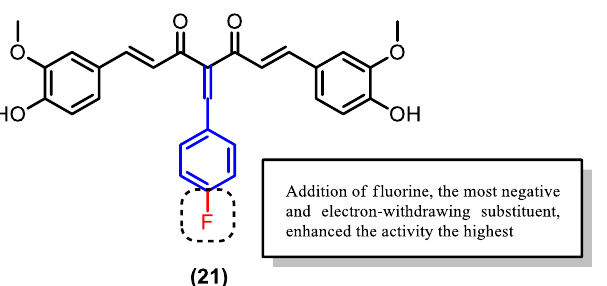
Figure 17. Curcumin derivative ( 21 ) had the highest potency among the synthesized Knoevenagel condensate derivatives.